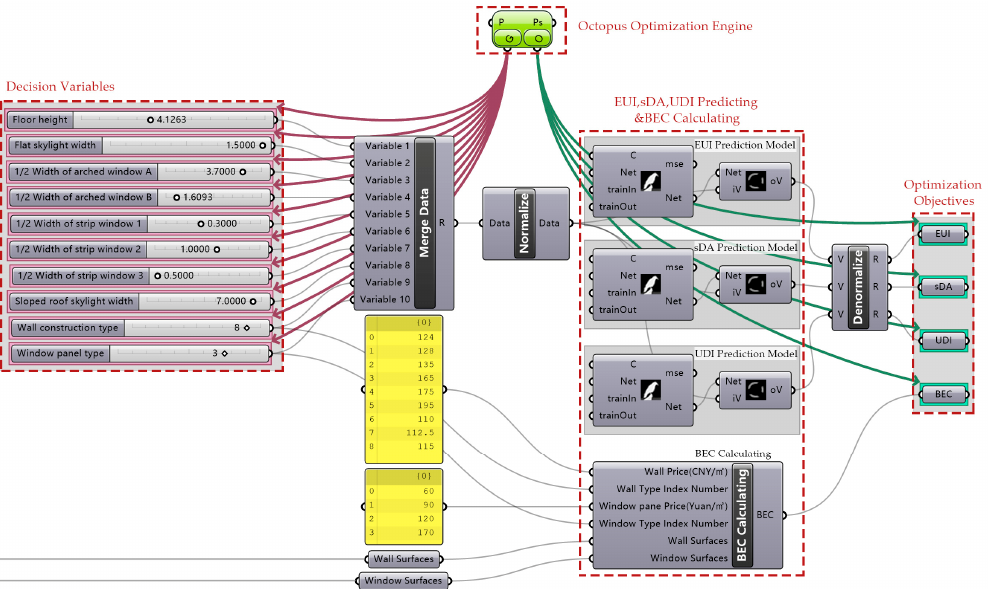
Figure 11. Many-objective optimization module.